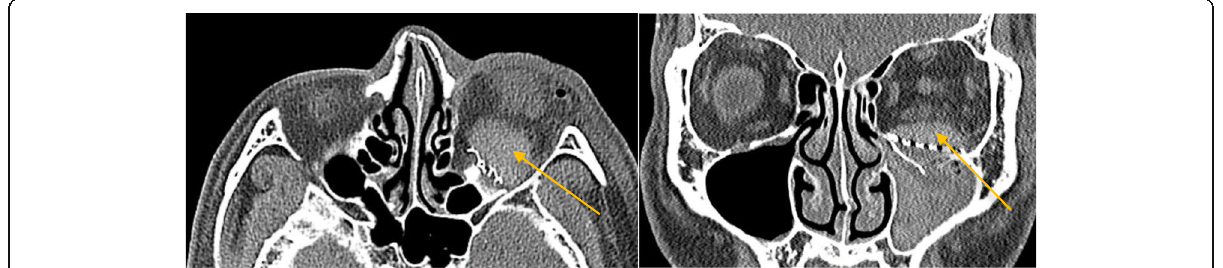
Fig. 8 Postoperative CT (axial and coronal sections) showing retrobulbar hematoma (yellow